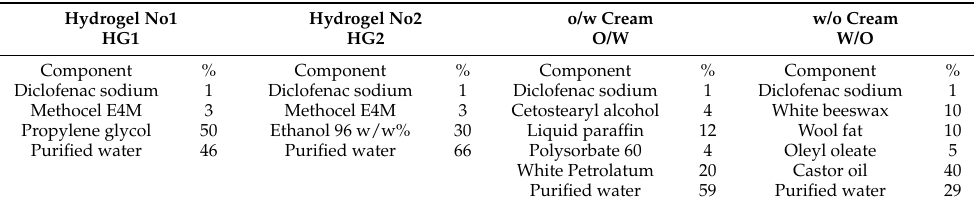
Table 1. Compositions of the test